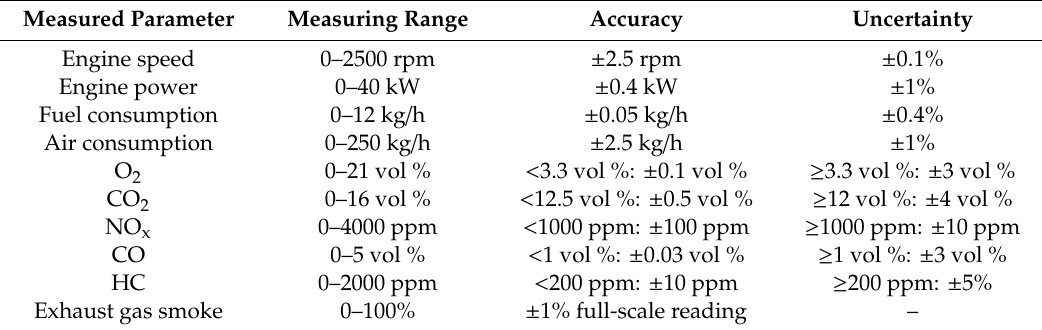
Table 2. Main measurement parameters.